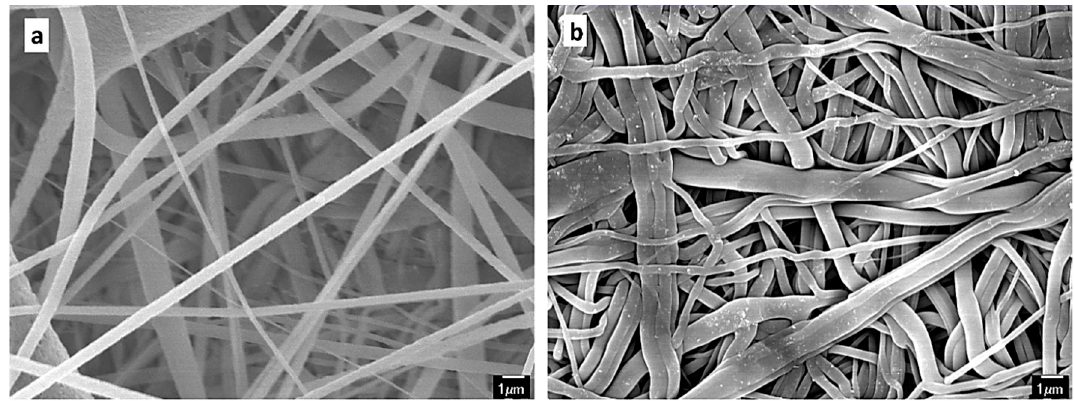
Figure 3. Surface SEM images of the ( a ) polyvinylidene fluoride (PVDF) and ( b ) polyethersulfone (PES) membranes at a magnification of 5000×.